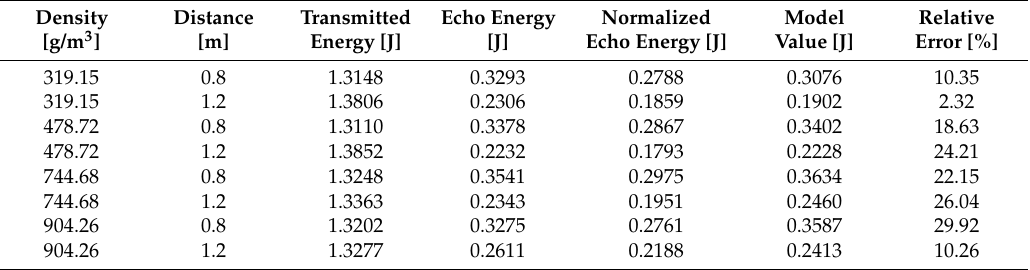
Table 12. Canopy density model universal analysis with two layers of